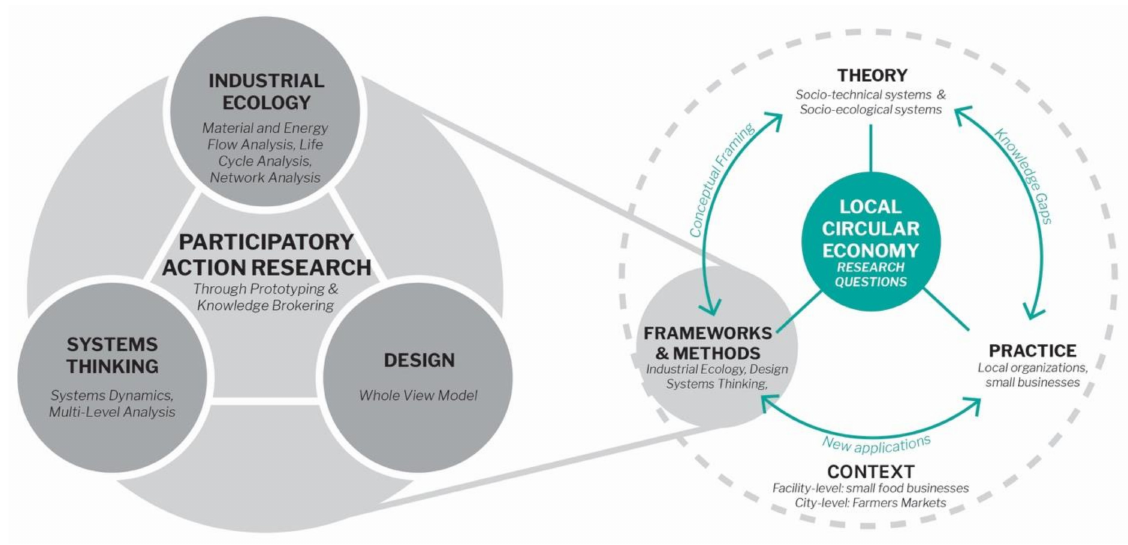
Figure 1. Underlying structure of the research